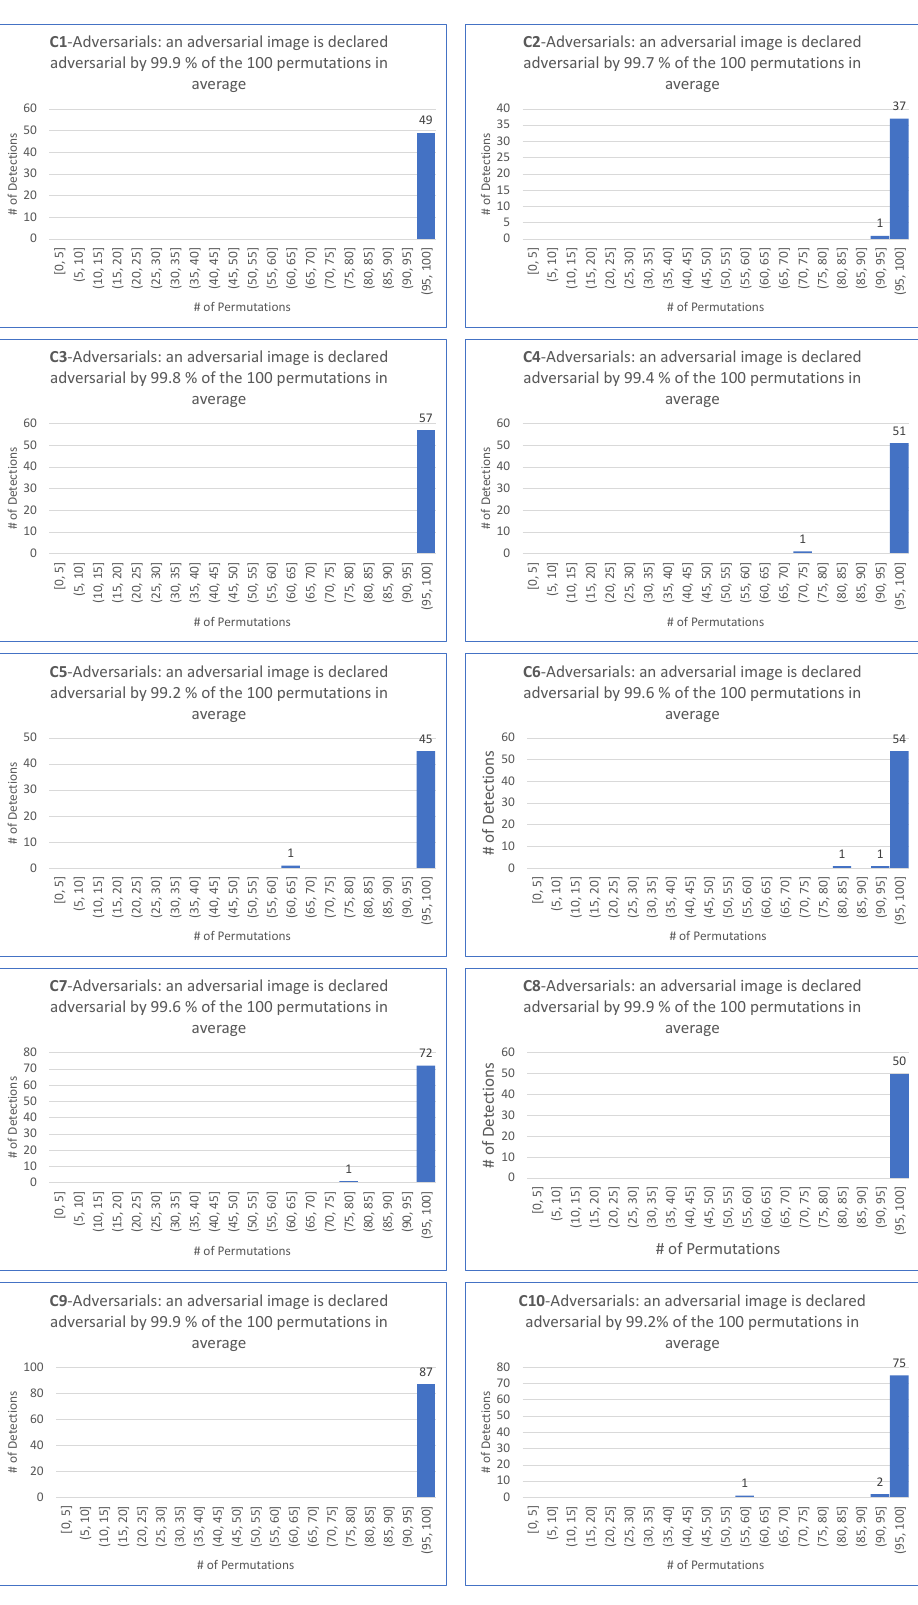
Figure A5. ShuffleDetect results for adversarial images generated by the PGD Inf-targeted attack on C = C for 1 ≤ k ≤ 10 over 100